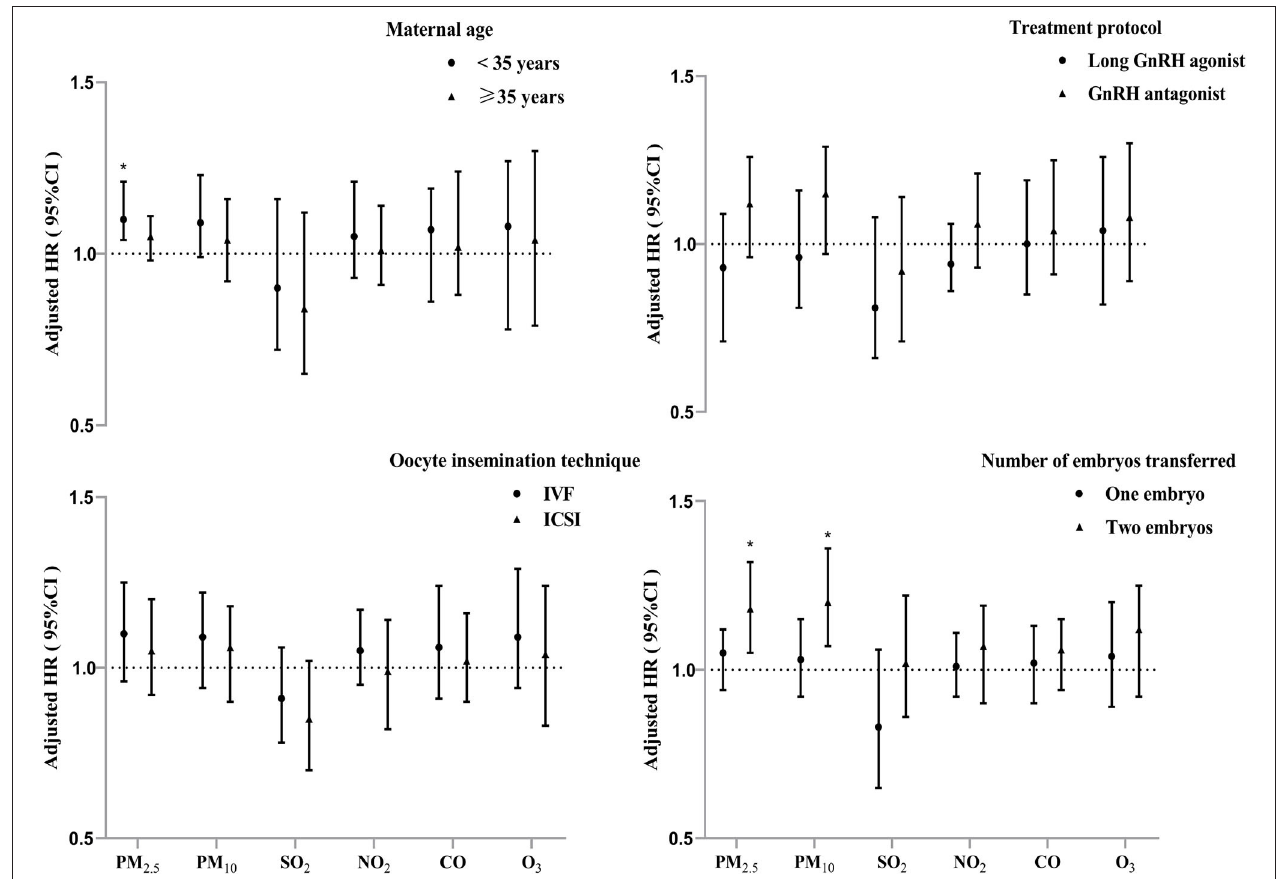
FIGURE 4 | Adjusted hazard ratios (95% confidence intervals) of PTB risk per interquartile range increment in air pollutants exposure during IVF pregnancy (period I) stratified by potential modifiers. * P <